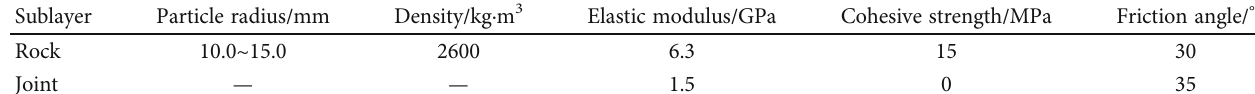
Table 1: Mechanical parameters of rock and